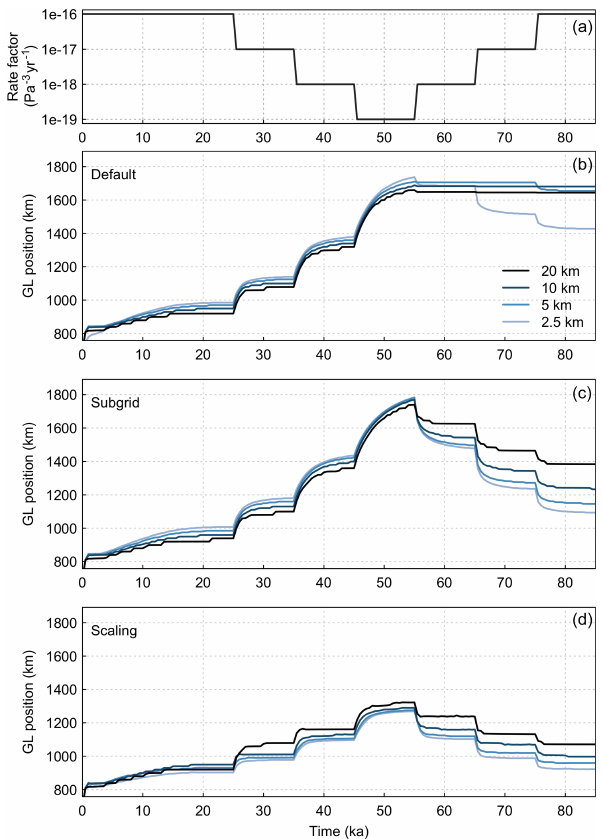
Figure 8. Yelmo performance in the MISMIP bedrock advance and retreat simulations on a linear sloping bed. Panel (a) shows the im- posed rate factor A , with 10kyr steps of decreasing and then in- creasing values. Panels (b) , (c) and (d) show the grounding line position evolution for each of three model configurations, respec- tively: “Default” is the standard model setup, with no special treat- ment of friction at or near the grounding line; “Subgrid” uses the grounded fraction at the grounding line to scale the basal friction; and “Scaling” applies both the grounded fraction and imposes a lin- ear reduction in basal friction as the ice sheet approaches flotation. Separate simulations were run for resolutions ranging from 20km down to 2.5km.